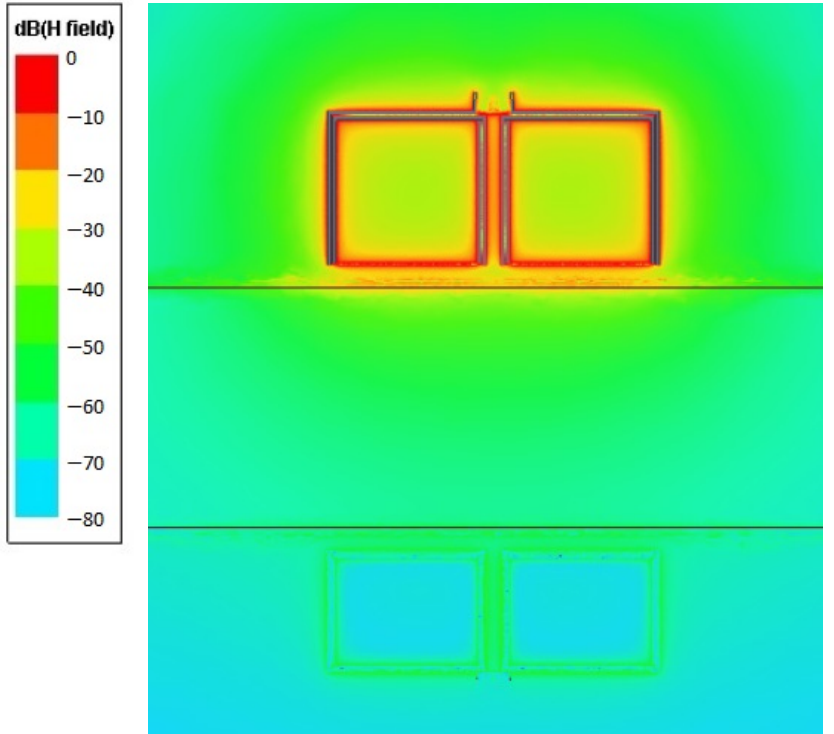
Figure 18. Magnetic field distribution at the operative frequency (i.e., 1.5 GHz) for the TX/RX micro-antenna configuration (design step E).